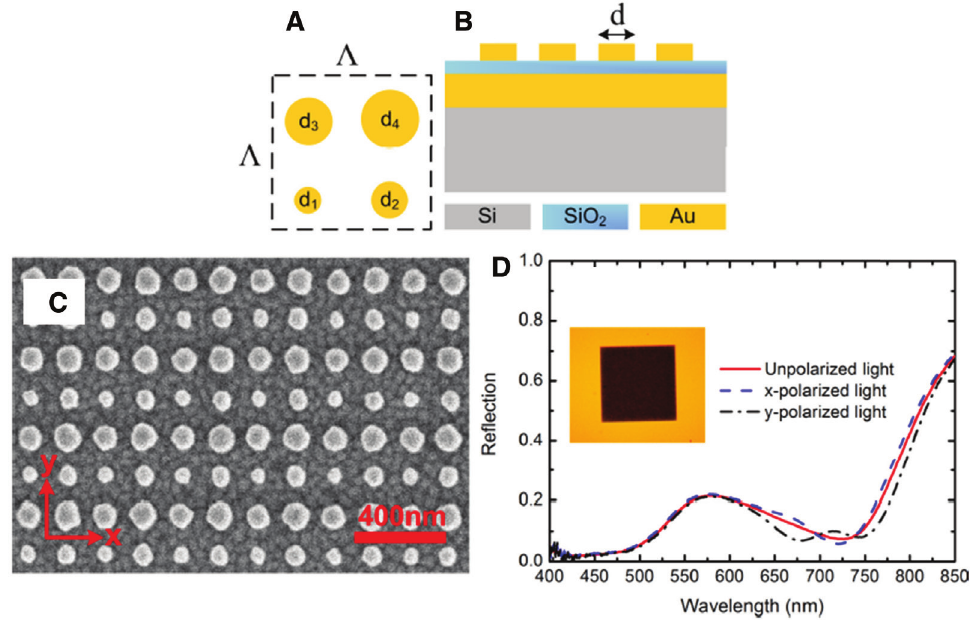
Figure 20: (A) Geometry of the sample studied by Nielsen et al. [48]. The unit cell is quadratic of size Λ and contains four gold nanoparticles with different diameters. (B) Schematic representation of the layered sample structure. (C) Top-view SEM image of the fabricated CL-GPRs with particle diameters d1 = 60 nm, d2 = 80 nm, d3 = 100 nm and d4 = 120 nm and unit-cell size Λ = 340 nm. (d) Reflection spectra for unpolarized (solid red curve), x-polarized (dashed blue curve) and y-polarized (black dash-dotted curve) light. The inset shows a microscope image of the 30 μ m × 30 μ m CL-GPR array for unpolarized light and its appearance compared to the surrounding smooth gold film coated with ∼ 20 nm SiO Reprinted figure with permission from M. G. Nielsen, A. Pors, O. Albrektsen, and S. I. Bozhevolnyi, Optics Express, vol. 20, pp. 13311 (2012). Copyright 2012 by the Optical Society (OSA).